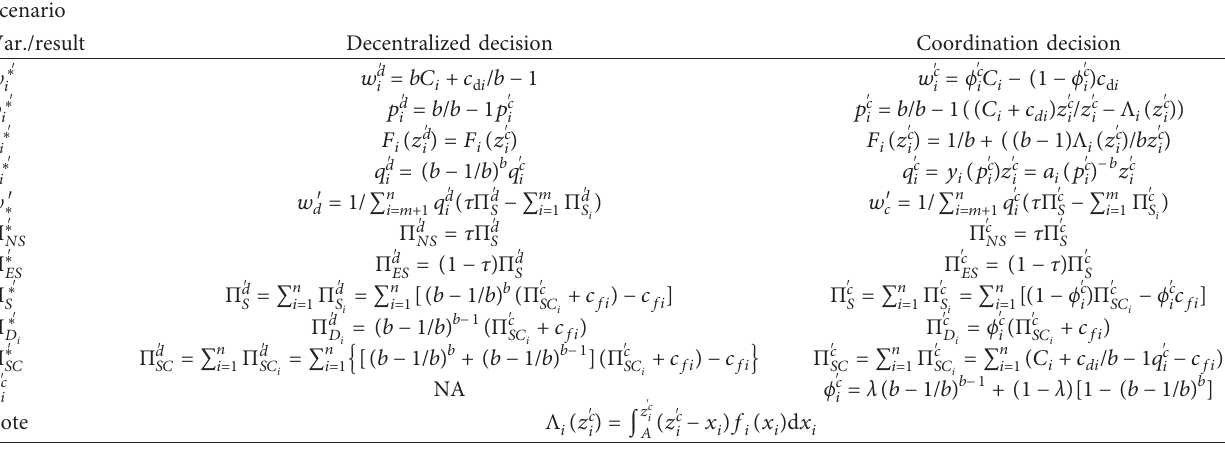
Table 4: Analytical results of IBWT green supply chain without WGD effort ( θ � 0 , κ � 0).